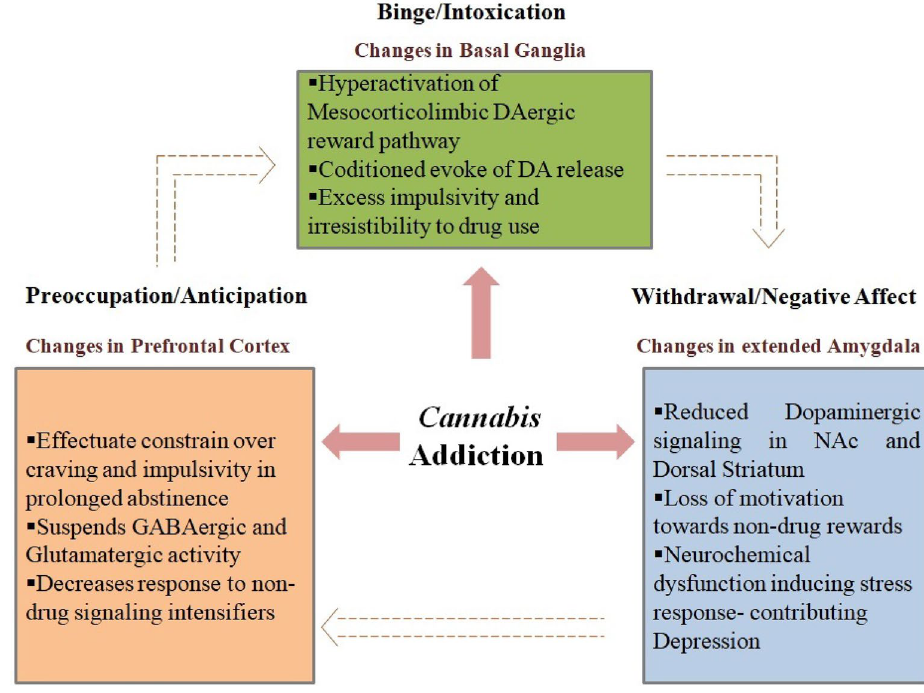
Fig. 3 Stages of drug addiction: binge/intoxication stage, withdrawal/negative affect stage and preoccupation/anticipation